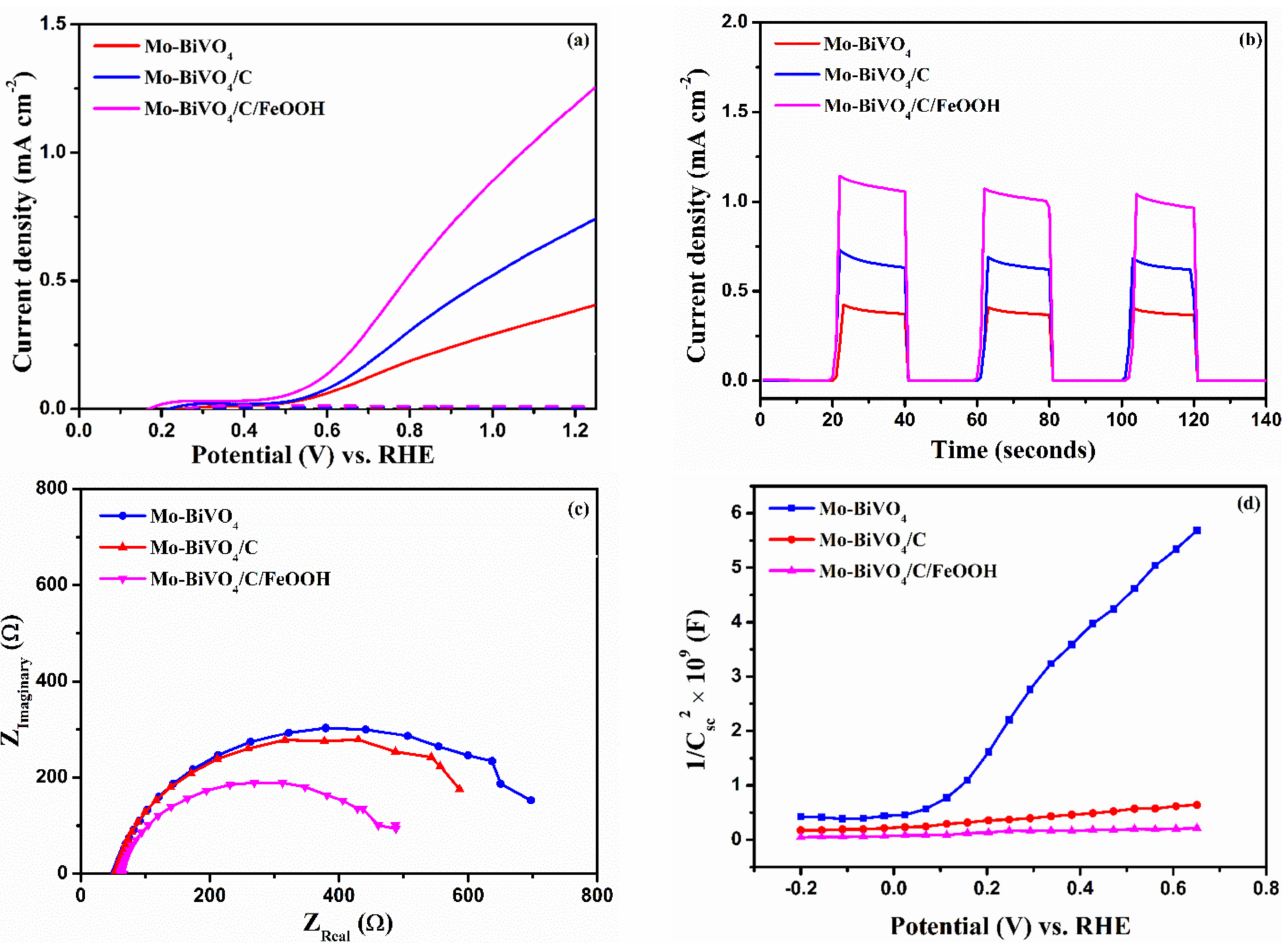
Figure 4. ( a ) Linear sweep voltammetry (LSV) curves, ( b ) J vs. t at 1.23 V vs. RHE, ( c ) Electrochemical impedance spectroscopy (EIS), and ( d ) Mott–Schottky plots of Mo-BiVO 4 , Mo-BiVO 4 /C, and Mo- BiVO 4 /C/FeOOH photoanodes using an AM 1.5 G illumination source with a power intensity of 100 mW cm − 2